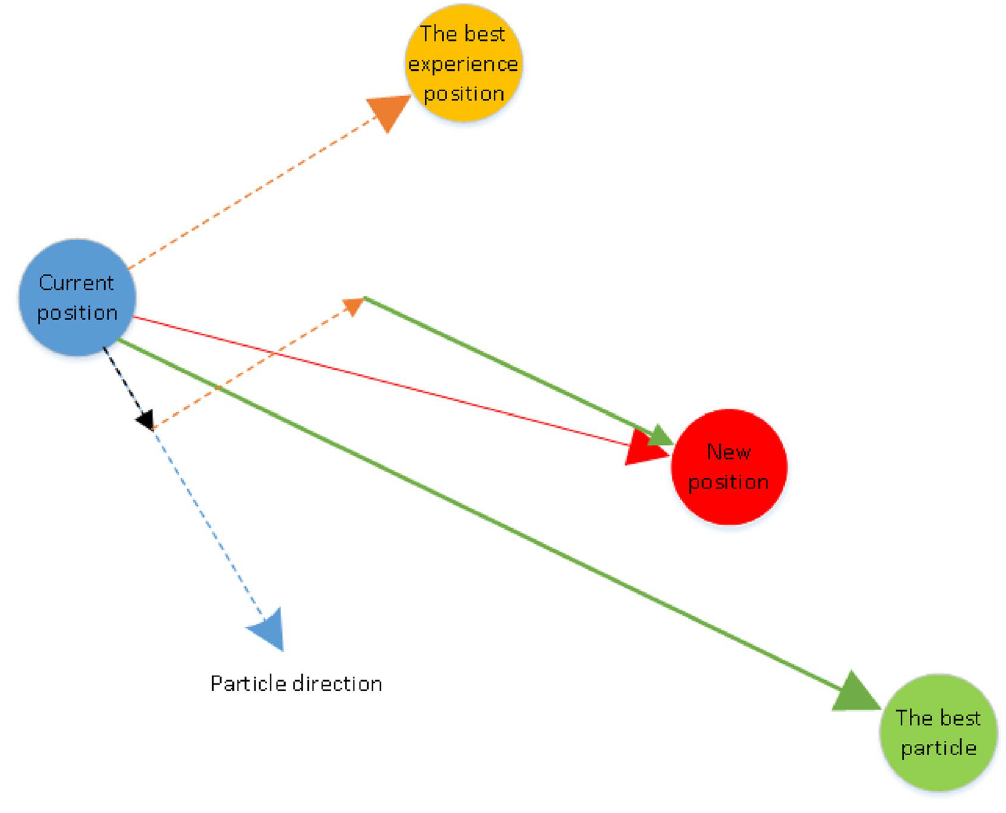
Figure 2. Schematics of PSO